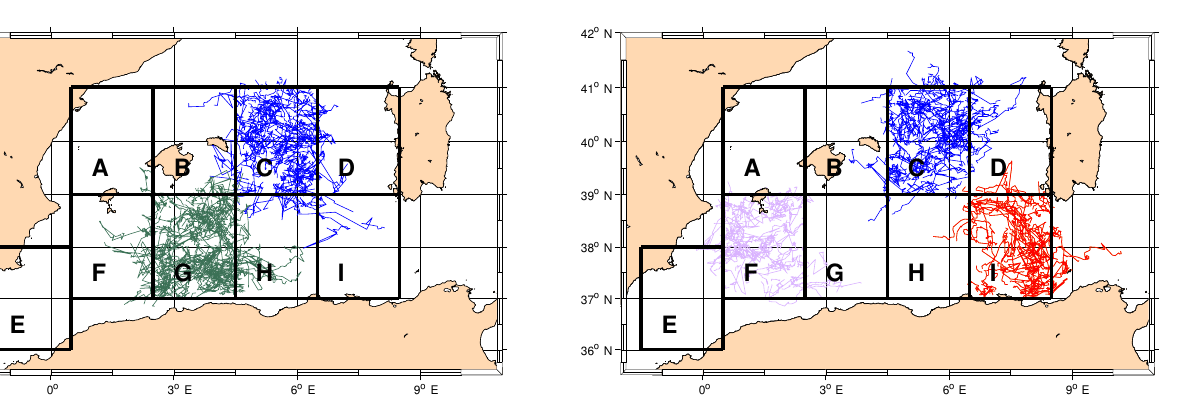
Figure 11. Tracks of the cyclonic eddies formed in sectors C (blue) and G (green).